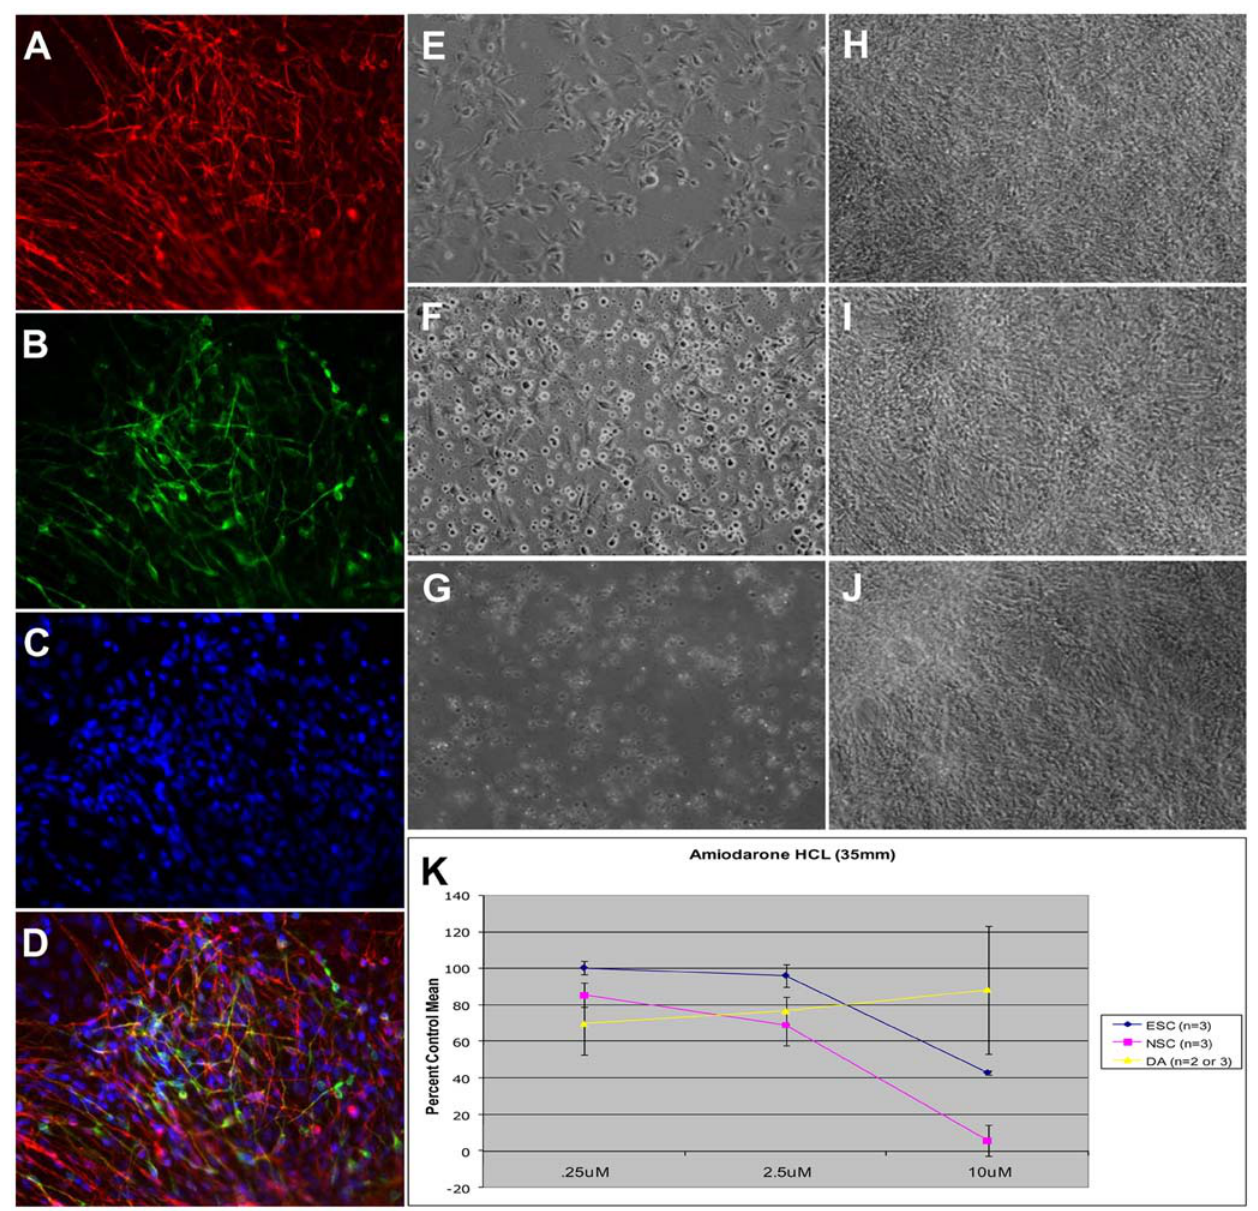
Figure 3. Validation of a compound in larger numbers of cells. (A–D) Expression of b -III tubulin (A, red) and TH (B, green) in NSCs that had been differentiated for 4 weeks (C=nuclei, blue, D=merge). (E–G) NSCs after 2 (E), 4 (F) and 8 (G) hours exposure to amiodarone HCl (H–J) dopaminergic neurons after 2 (H),4 (I) and 8 (J) hours exposure to amiodarone HCl. (K) Changes in ATP levels in hESC (blue line), NSC (pink line) and dopaminergic neurons (yellow line) after exposure to three doses of amiodarone HCl for 48 h (at 10 um NSC v DA p , 0.001, N=3